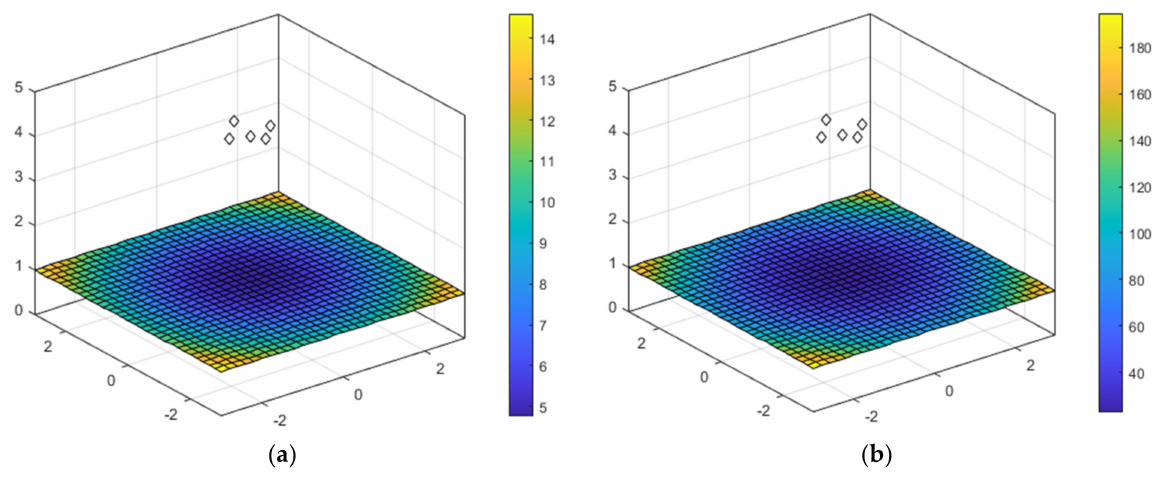
Figure 7. Study of the PDOP considering a 6 m × 6 m area in the XY plane, and five beacons placed at a height of 348 cm, in a 70.7 cm × 70.7 cm square structure: ( a ) spherical; ( b )